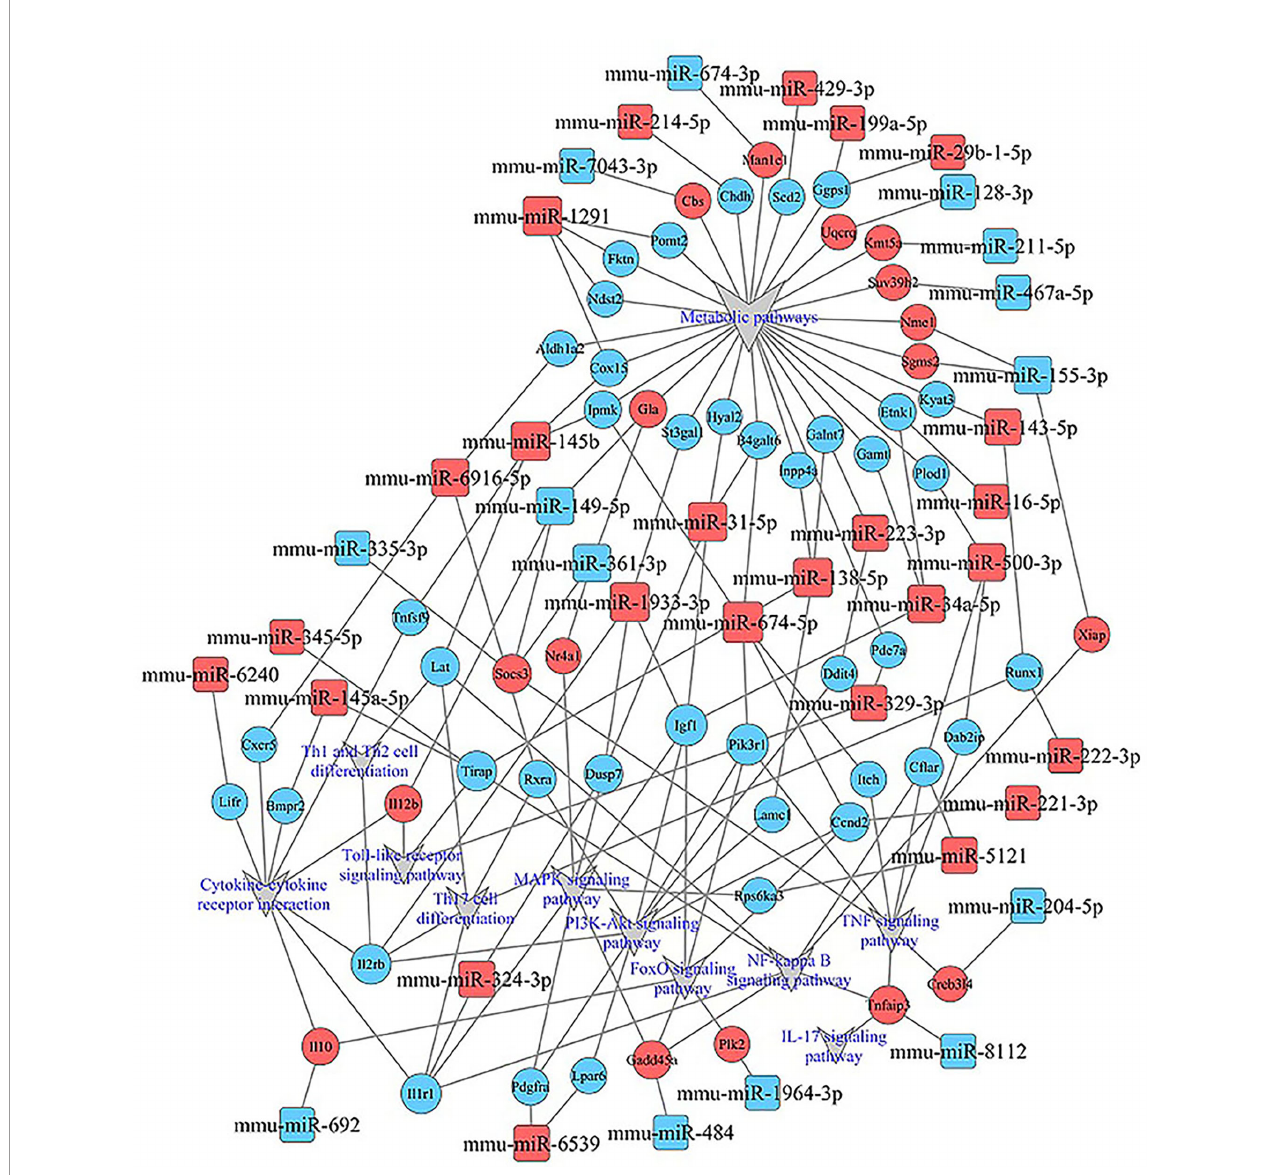
FIGURE 9 | miRNA – mRNA-pathway-net. Squares indicate identi fi ed miRNAs, while circles represent the corresponding target genes. Blue indicates down-regulated miRNAs or mRNAs while red indicates up-regulated miRNAs or mRNAs. The relationship between miRNAs and genes is shown connected by gray lines. Eleven signi fi cantly enriched pathways associated with splenocytes stimulated by Kyn were depicted using the gray triangles. More details about immune related miRNA – mRNA-pathway are shown in Supplementary Figure 3